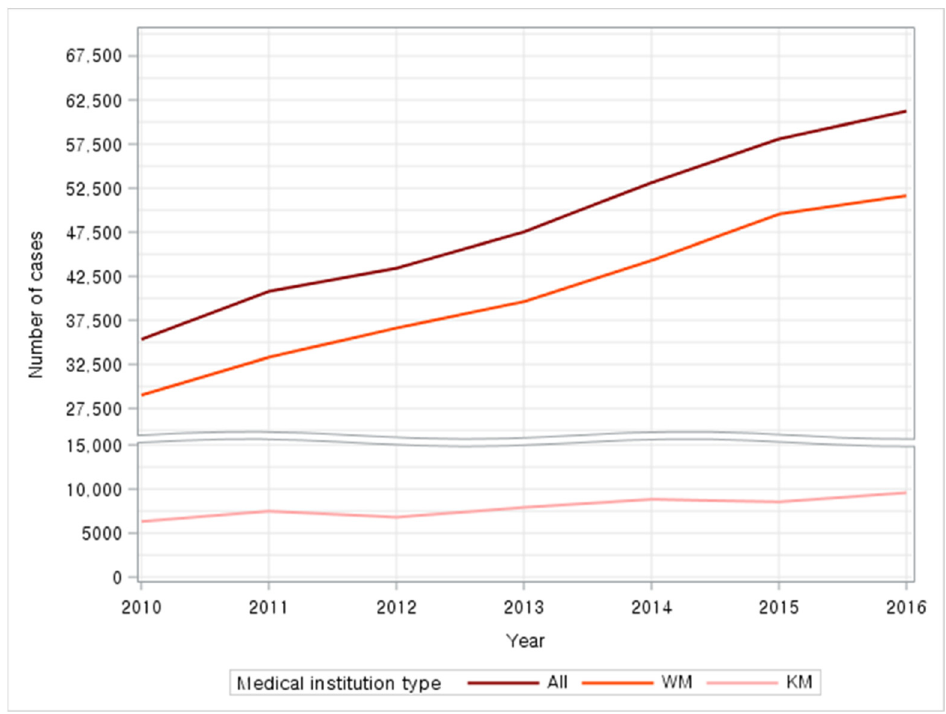
Figure 2. General medical service use for insomnia—number of cases; WM = Western medicine; KM = Korean medicine.